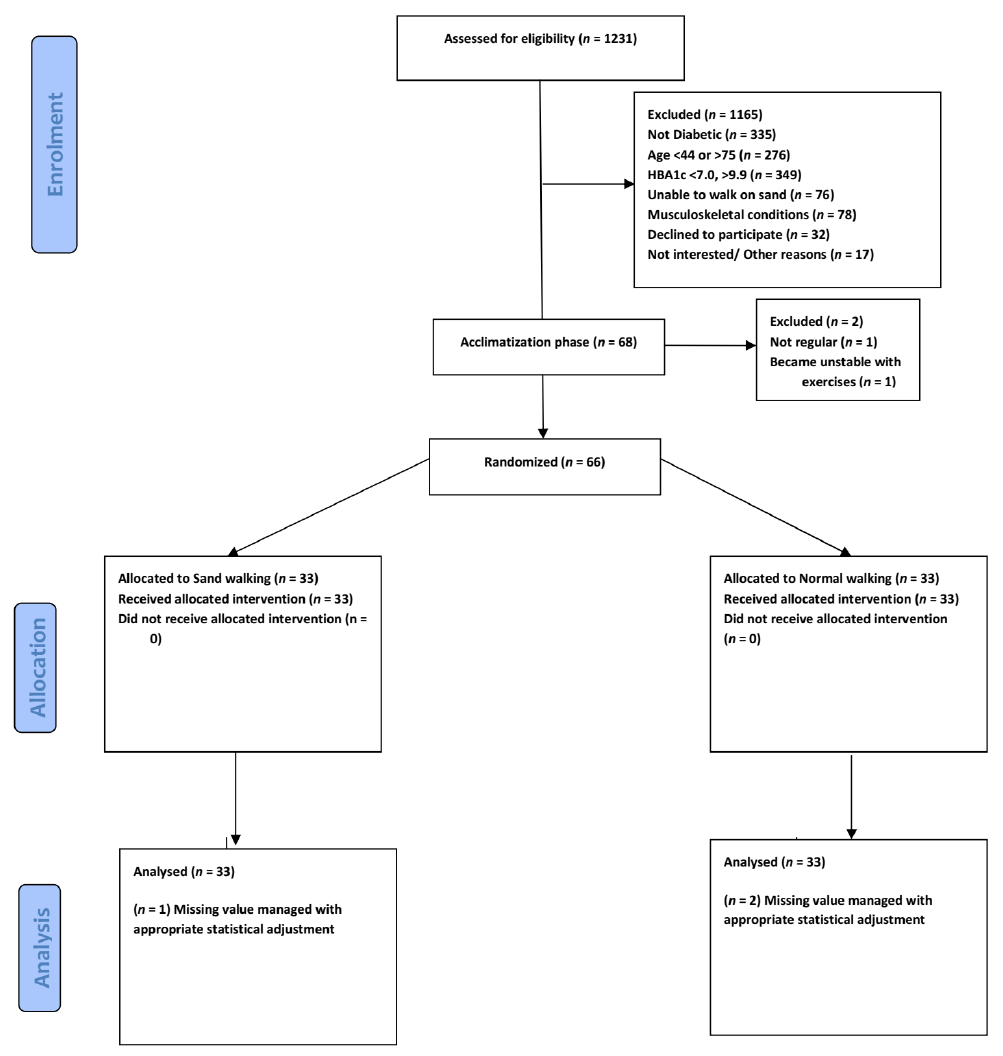
Figure 1. Consolidated Standards of Reporting Trials of participants through enrolment, allocation, and Analysis.